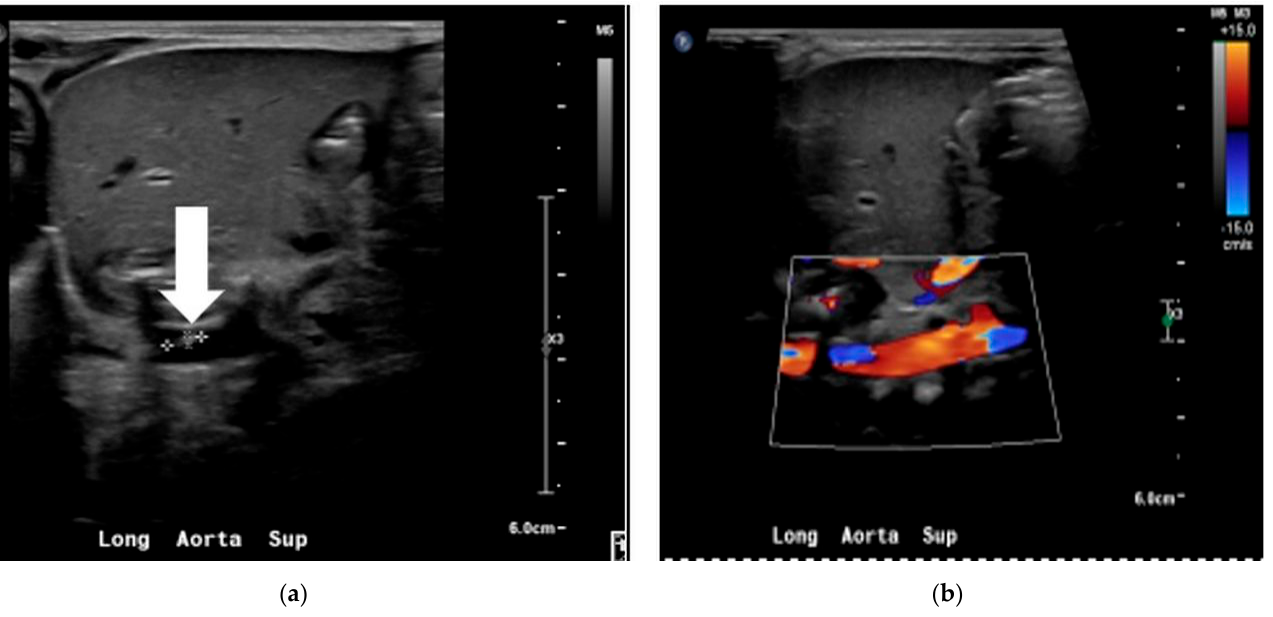
Figure 1. Aortic doppler study showing the non ‐ occlusive thrombus in the grayscale ( a ) and color doppler ( b ).